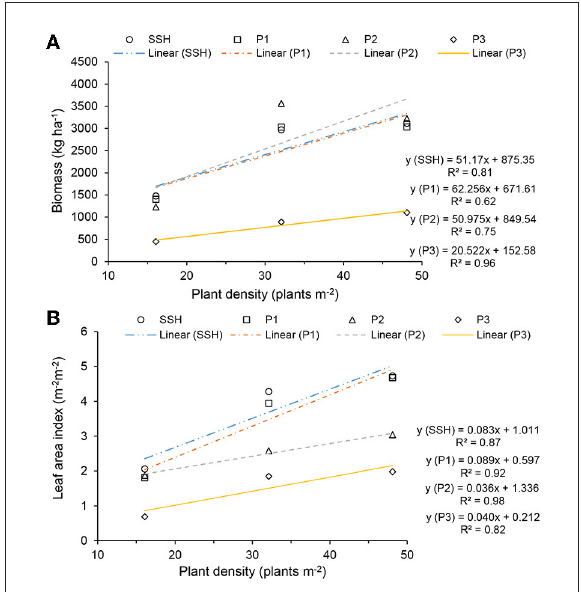
FIGURE5 Sunn hemp biomass (kg ha − 1 ) (A) and leaf area index (m − 2 m − 2 ) (B) as a function of plant density per area (SSH, sole sunn hemp; P1, simultaneous sunn hemp and maize planting; P2,